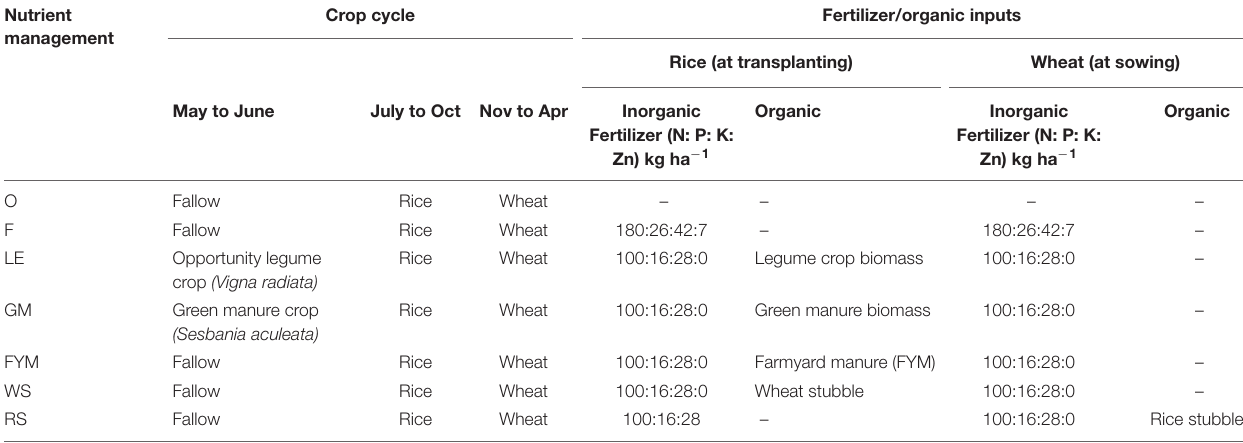
TABLE 2 | Fertilizer nutrient application and organic inputs under different nutrient management systems. Nutrient management